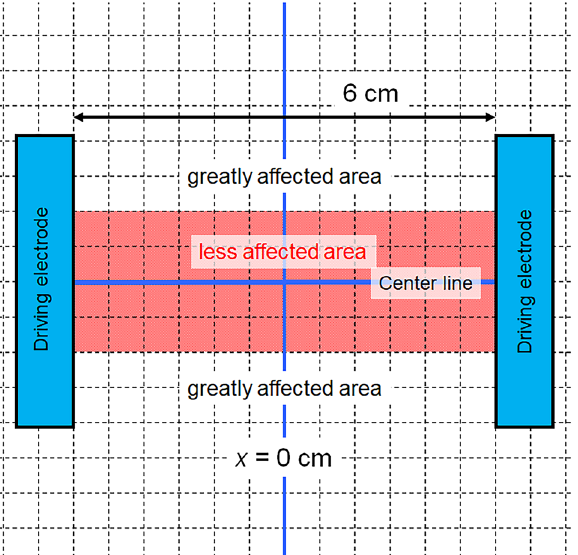
Figure 5. Schematic of the recommended area (in red) to place BPEs in for bipolar anodization. The grid is drawn with a spacing of 5